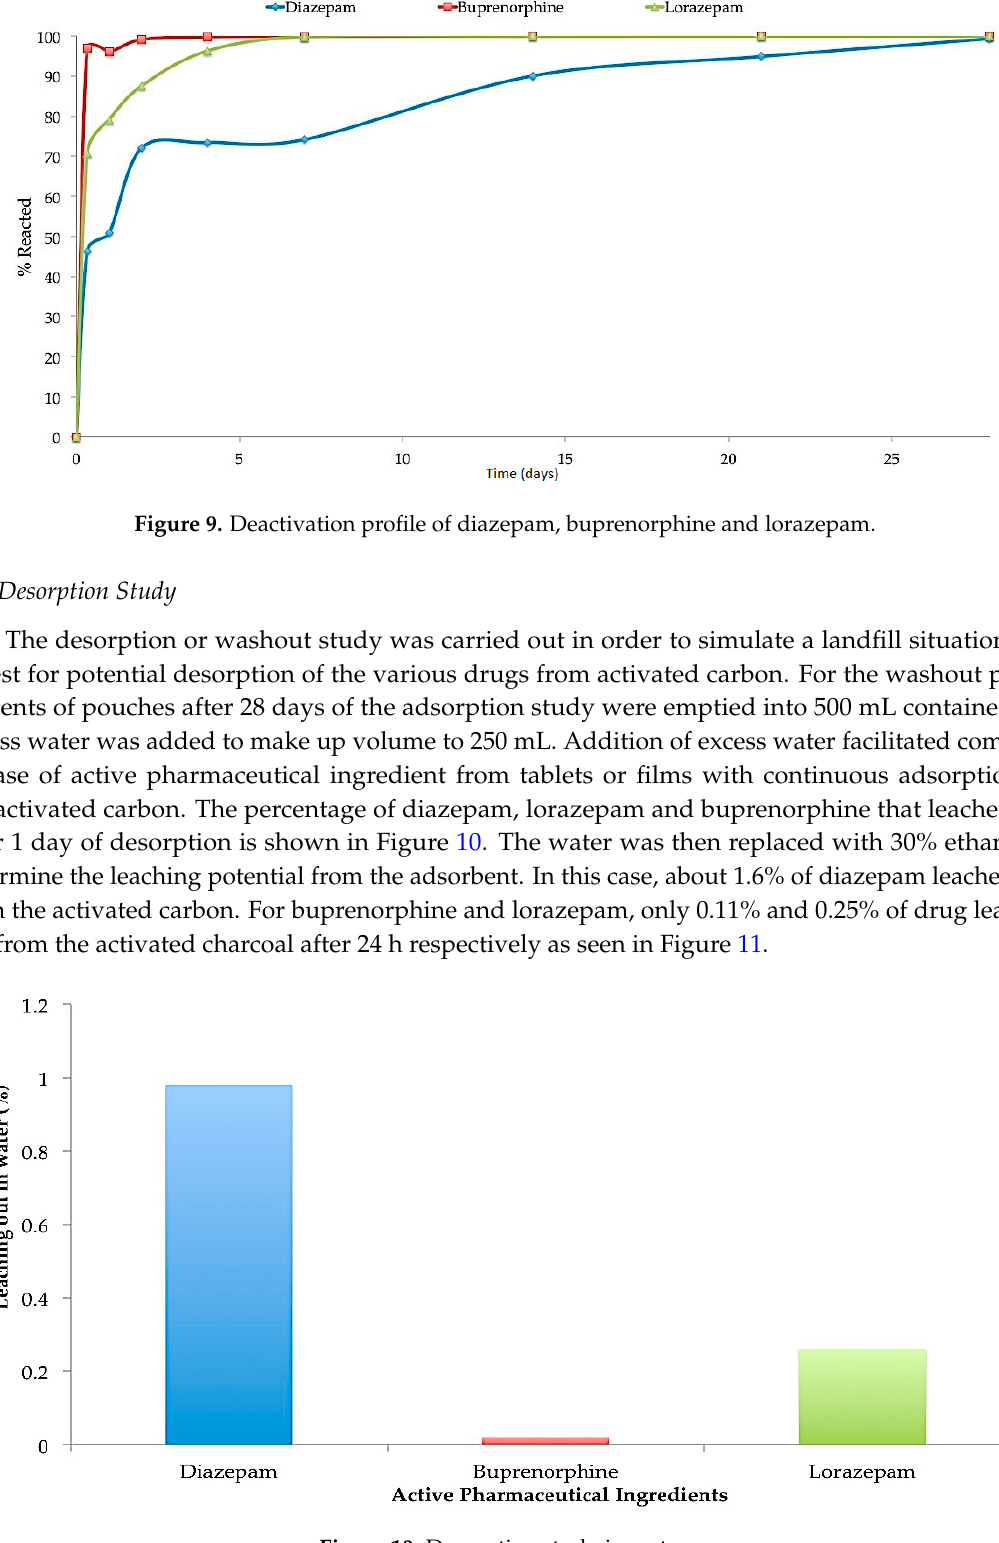
Figure 10. Desorption study in water.